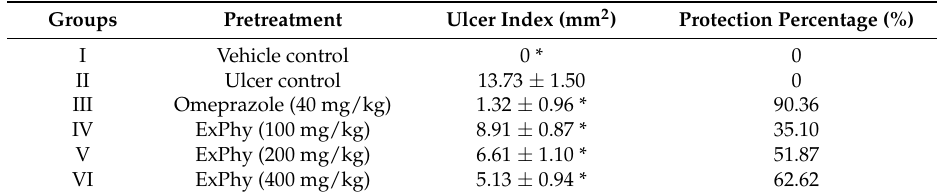
Table 3. Effect of ExPhy and omeprazole on ulcer parameters in rats with ethanol-induced ulcers.